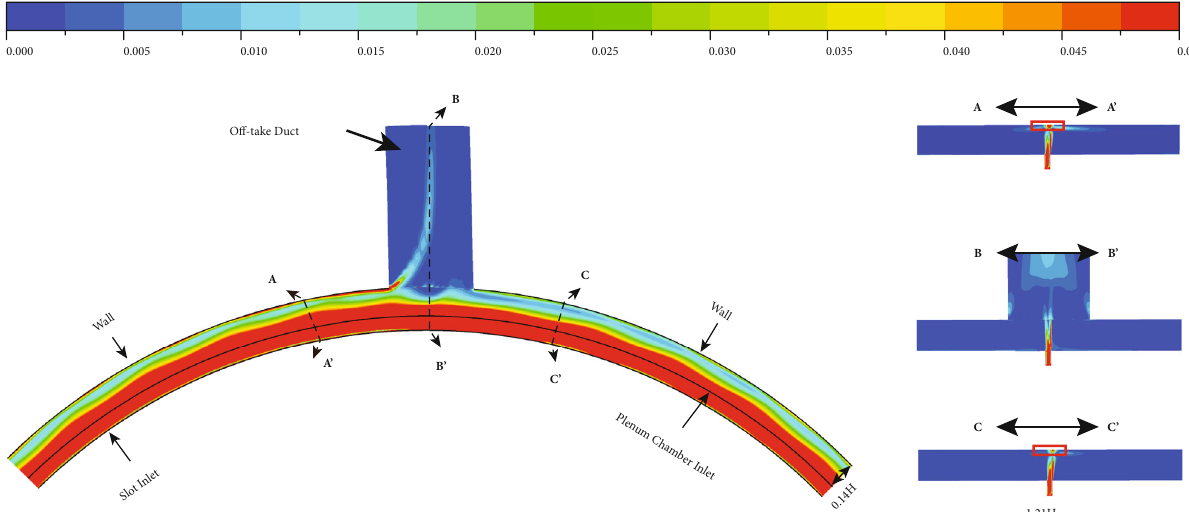
Figure 16: Normalized entropy generation rate of bleed system for plenum chamber with a radial height of 0.14 H and an axial width of 1.21 H